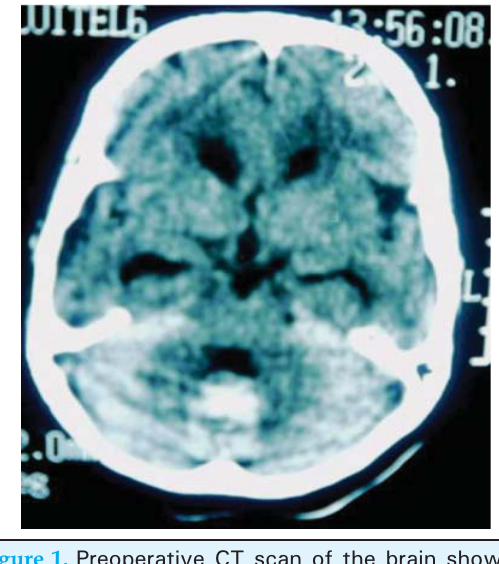
Figure 1. Preoperative CT scan of the brain showing blood in the fourth ventricle with obstructive hydrocephalus